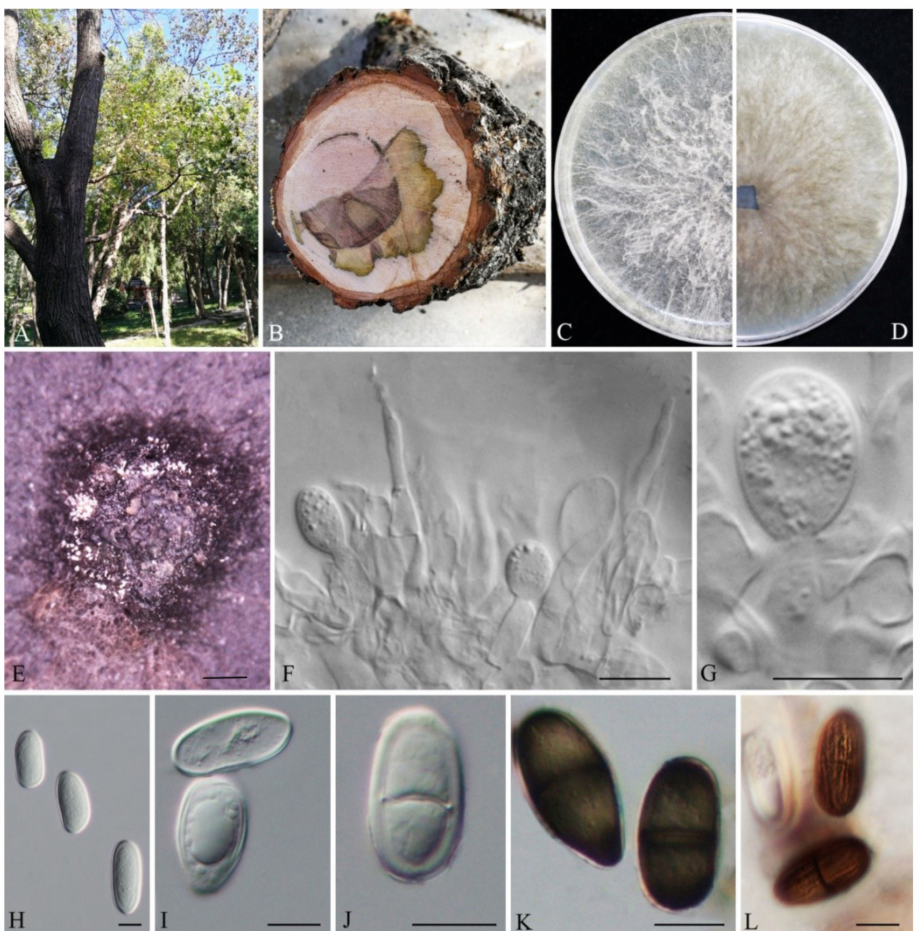
Figure 2. Lasiodiplodia acerina (JZBHD 1904). ( A ) Disease tree in the field. ( B ) Cross-section of stem. ( C , D ) Culture grown on PDA. ( E ) Conidiomata developing on PDA. ( F , G ) Conidia developing on conidiogenous cells between paraphyses. ( H – L ) Conidia. Scale bars: E = 200 µ m, F − L = 10 µ